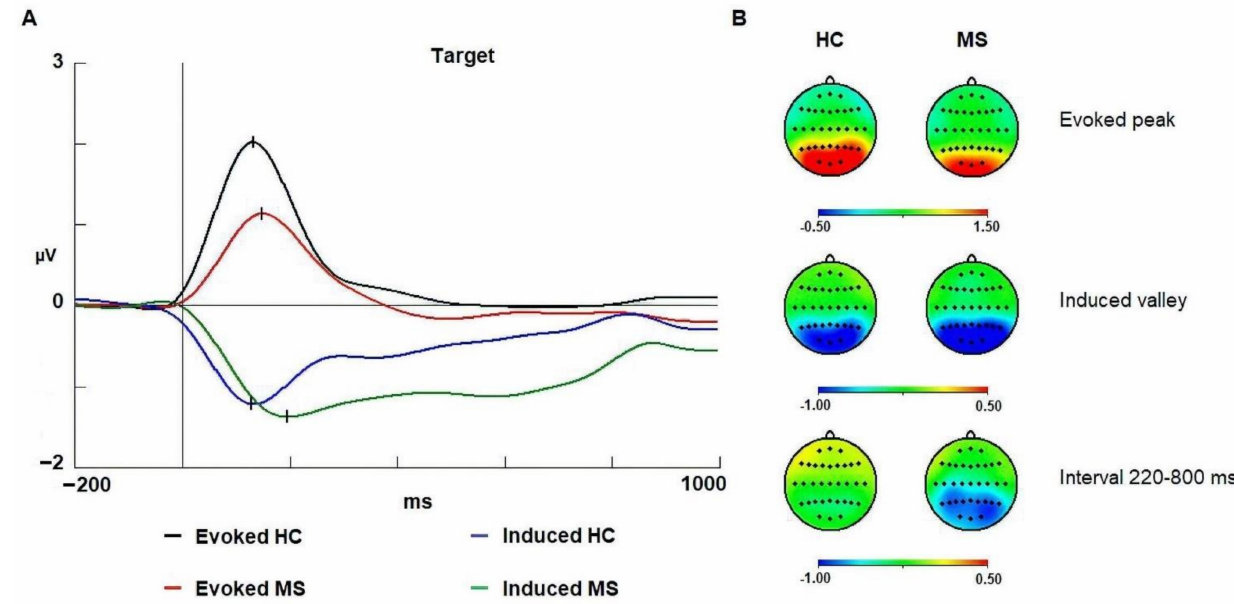
Figure 3. Spectral activity of alpha band in both groups. ( A ) Evoked and induced waves for the alpha band (8–13 Hz) in the visual oddball task. ( B ) 2D head maps for the peak and valley latencies of evoked and induced activity. Abbreviations: MS: multiple sclerosis; HCs: healthy controls; ms: milliseconds; µ V: